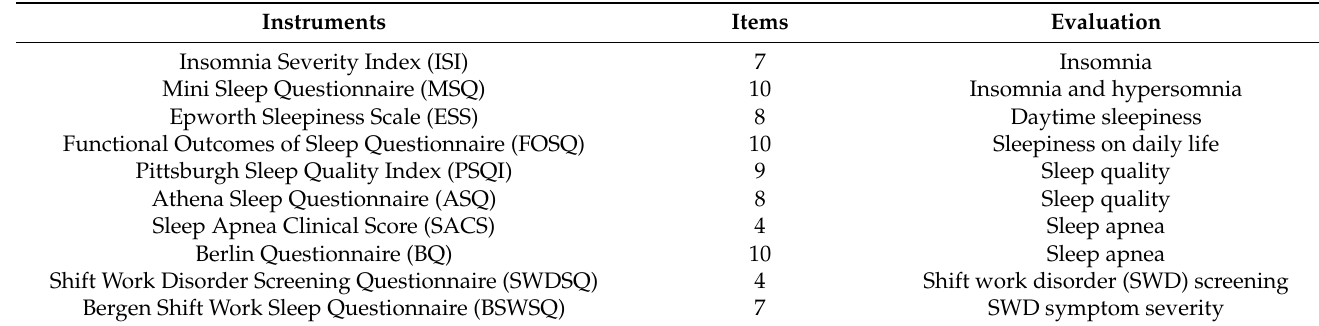
Table 1. Questionnaires for the evaluation of sleep